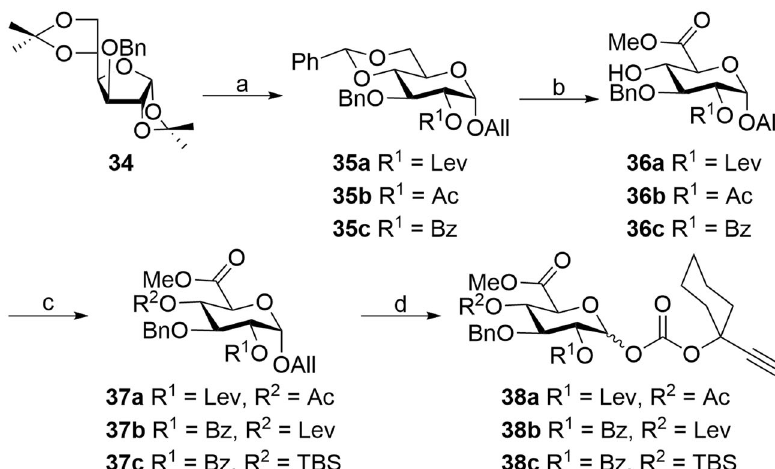
Fig. 4 Synthesis of glucuronic building blocks. reagents. a (i) TFA-H 2 O (9:1), 25 °C, 15 min, (ii) AcCl, AllOH, 0-80 °C, 16 h, 76% over two steps, (iii) PhCH(OMe) 2 , CSA, DMF, 25 °C, 4 h, 75%, (iv) LevOH, DIC, DMAP, CH 2 Cl 2 , 0 – 25 °C, 2 h, 35a : 92% or Ac 2 O/ BzCl, Pyridine, DMAP (cat), 0 – 25 °C, 2